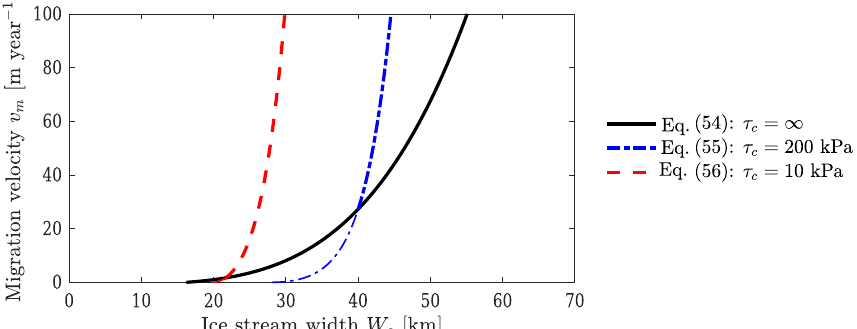
Figure 10. Margin migration velocities v m against ice stream width W s . Equation (54) is valid for no subtemperate slip, τ c = ∞ . Equa- tion (55) is valid for intermediate values of the subtemperate yield stress, formally when τ s (cid:28) τ c (cid:28) τ 2 s [ Ah 2 s /(kT m − kT b ) ] 1 / 4 . Equation (56) is valid for a small subtemperate yield stress (formally when τ c (cid:28) τ s ). Violation of the upper limit of validity of Eq. (55) leads to migration velocities that are less than the migration velocities without subtemperate slip (marked with thin blue line), which is unphysical, as subtemper- ate slip always increases migration velocities compared to no subtemperate slip. We used parameters listed in Table 1 and τ s = ρg sin αW s / 2 with sin α = 10 − 3